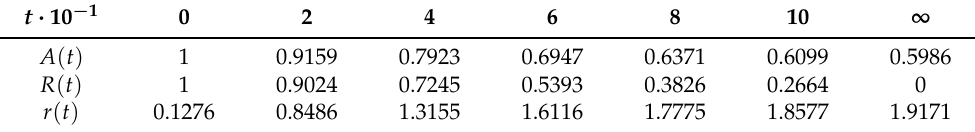
Table 1. Availability, reliability, and rate of failure of the system for different values of t